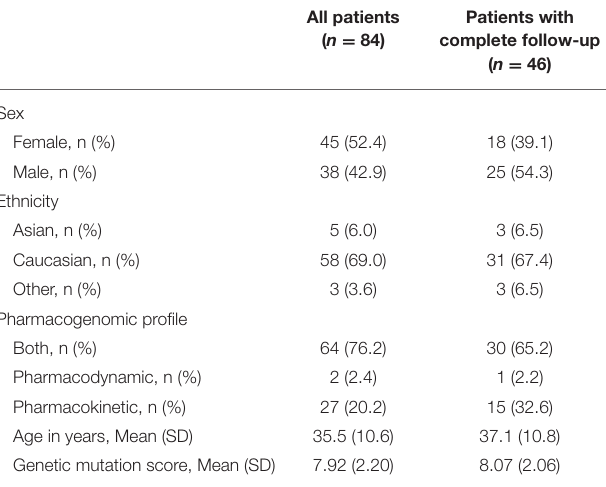
TABLE 2 | Characteristics of patients on mental health-related